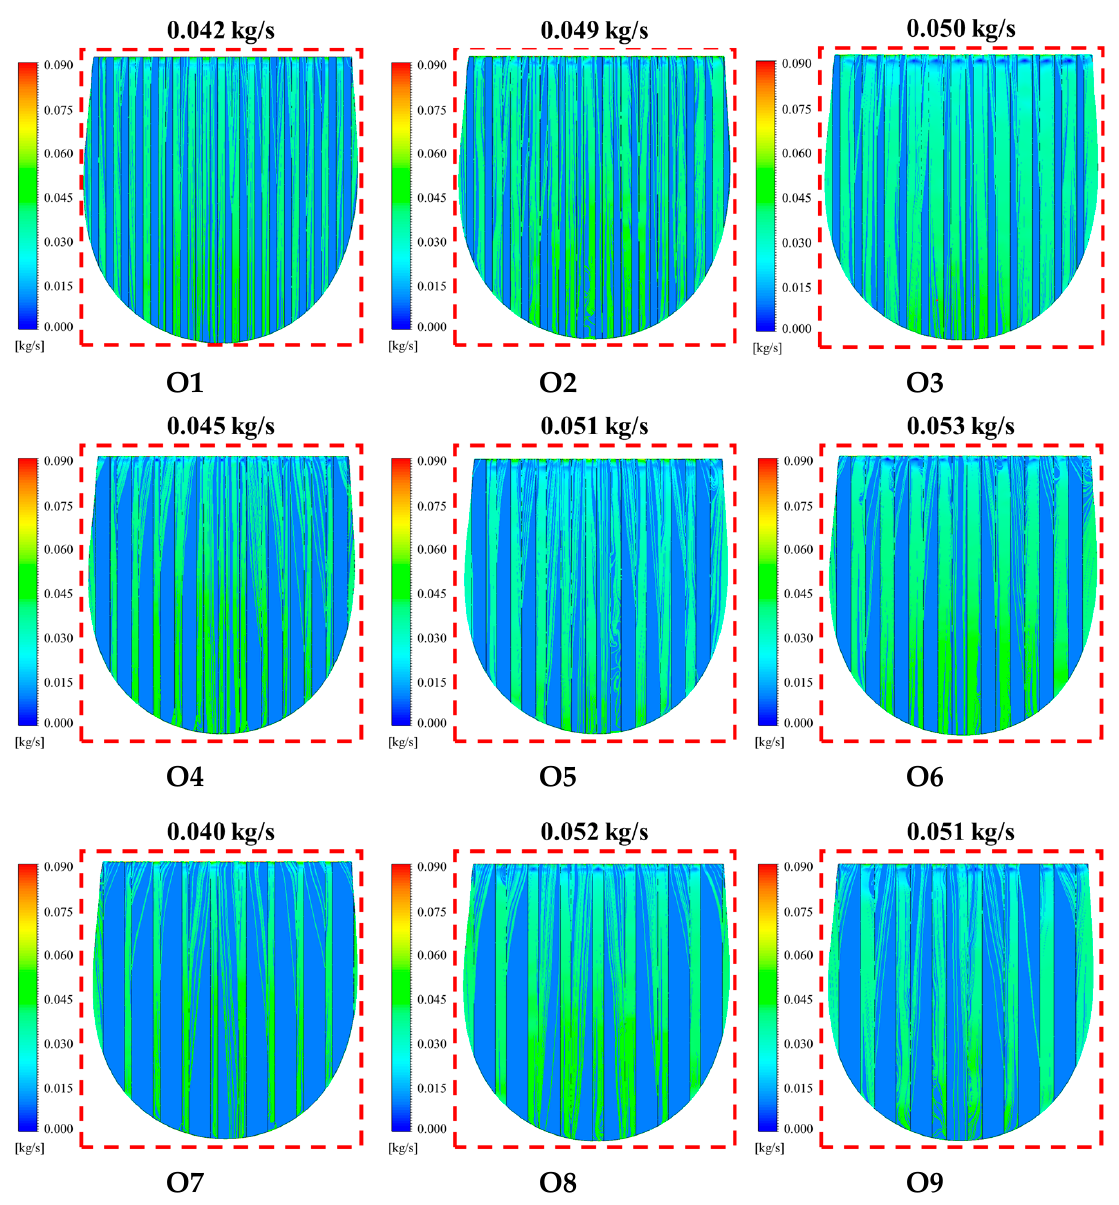
Figure 7. Mass flow rates across the outsole treads due to wet slipping simulations.